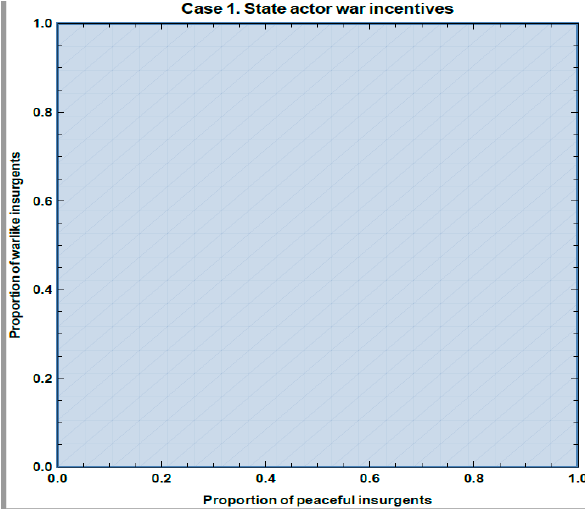
Figure 2. Fitness for state when r = 0.3, δ = 0.1, c = 0.2, and p = 0.5.